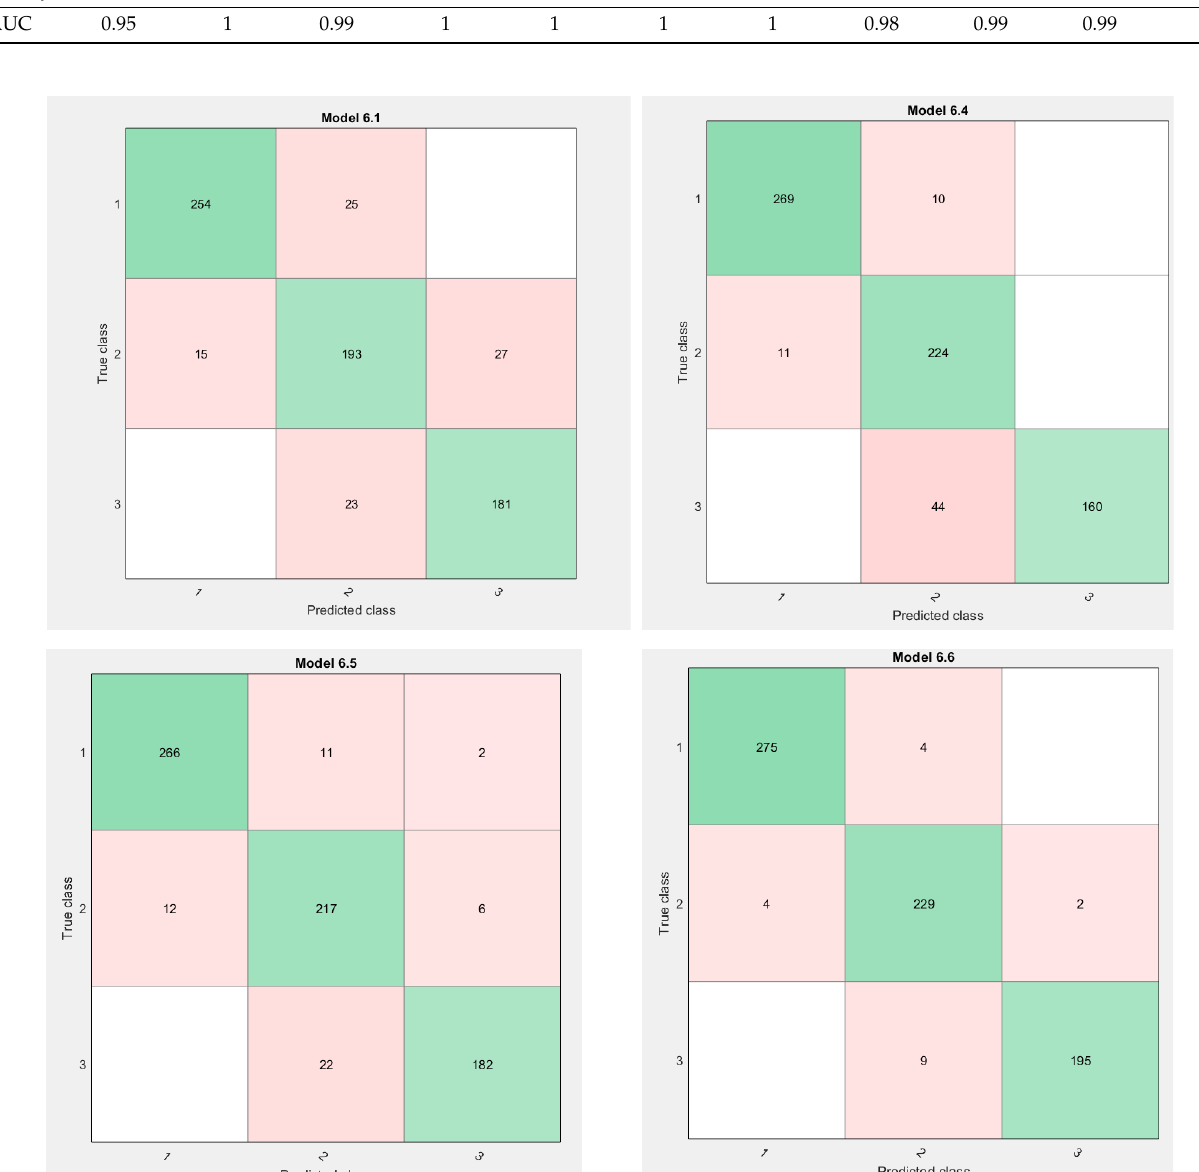
Table 3. Results show the classification accuracy and area under curve (AUC) for each of the classi- fiers. DT = Decision Tree, LDA = Linear Discriminant Analysis, QDA = Quadratic Discriminant Analysis, L-SVM = Linear Support Vector Machine, Q-SVM = Quadratic Support Vector Machine, C-SVM = Cubic Support Vector Machine, G-SVM = Gaussian Support Vector Machine, k-NN = K- Nearest Neighbor, BSE = Boosted Tree Ensemble, BGE = Bagged Tree Ensemble, and SDE = Subspace Discriminant Ensemble Learner. (TPR) and false positive rate (FPR). Our results showpromising results in terms of correct